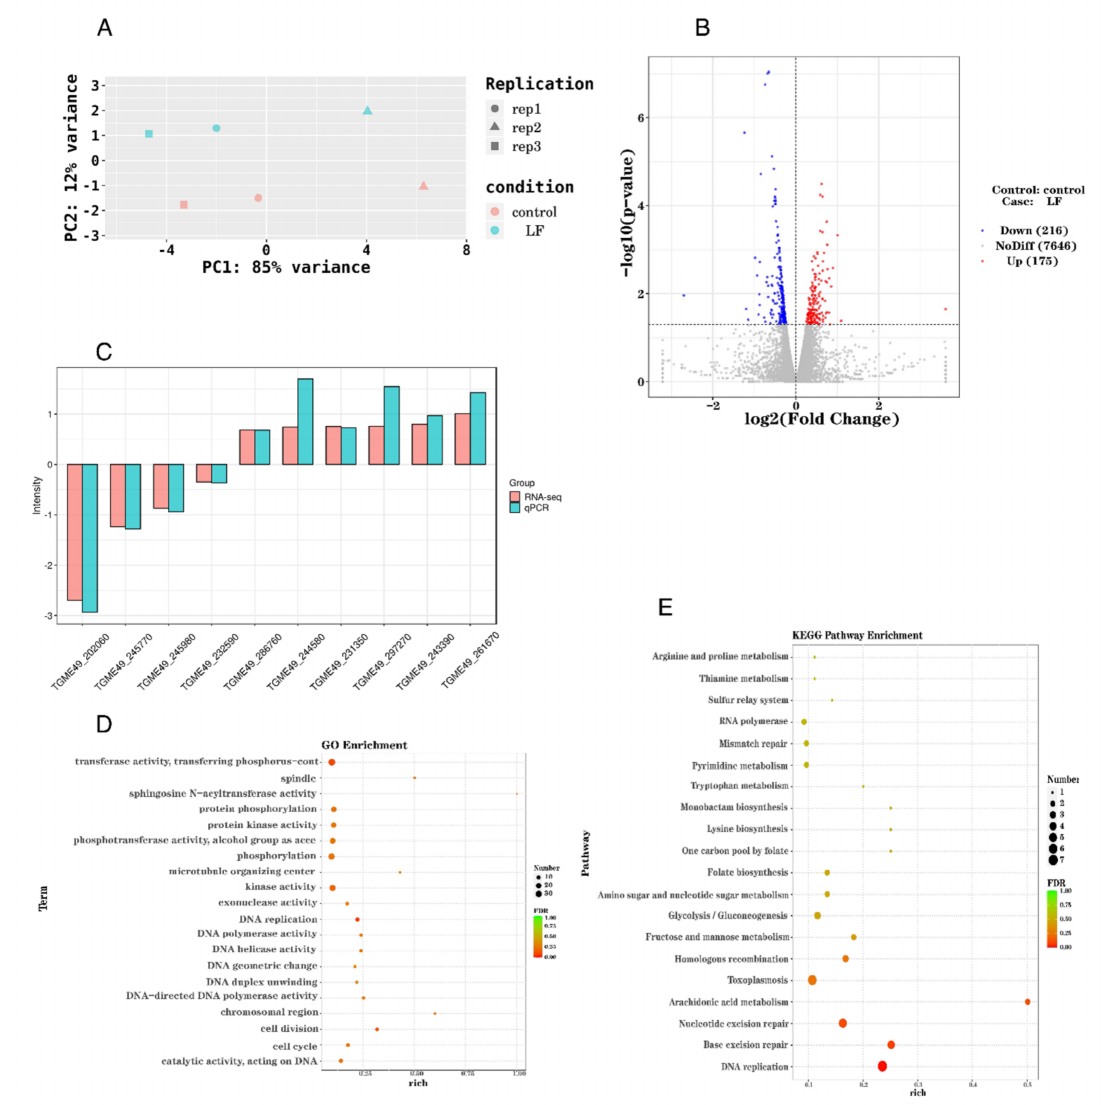
Figure 2. Transcriptome analysis of the effect of lumefantrine on T. gondii . ( A ) Transcriptome profile differences between groups and within groups were analyzed via principal components analysis (PCA). LF1, LF2, and LF3 are the three biological replicates of the drug treatment group. Control 1, 2, and 3 are three biological replicates of the control group without drug treatment. PC1, principal component 1; PC2, principal component 2. ( B ) The volcano map of differentially expressed genes. In this map, genes that were upregulated, downregulated, or not significantly affected were mapped. X -axis is the log2 fold change and the y -axis is the − log10( p -value). The horizontal line is the threshold of p -value = 0.05. Red dots indicate gene upregulation and blue dots indicate gene downregulation. Gray dots denote genes with no significant change. ( C ) Comparison between transcriptome data and qPCR data of the selected ten differentially expressed genes. Based on transcriptomic data, ten GEOs with high expression levels were selected for qPCR analysis. ( D ) Bubble chart of gene ontology (GO) enrichment analysis of differentially expressed genes. FDR (false discovery rate) ranges from zero to one. The closer FDR is to zero, the stronger the enrichment. The size of the dot denotes the number of DEGs. Rich factor is the ratio of the number of the DEGs to the total number of annotated genes. ( E ) Bubble chart of KEGG pathway analysis. The y -axis is the different KEGG pathways. The x -axis is the rich factor. Rich factor is the ratio of the number of the DEGs to the total number of annotated genes in this pathway. The size of the dot correlates with the number of DEGs annotated in the